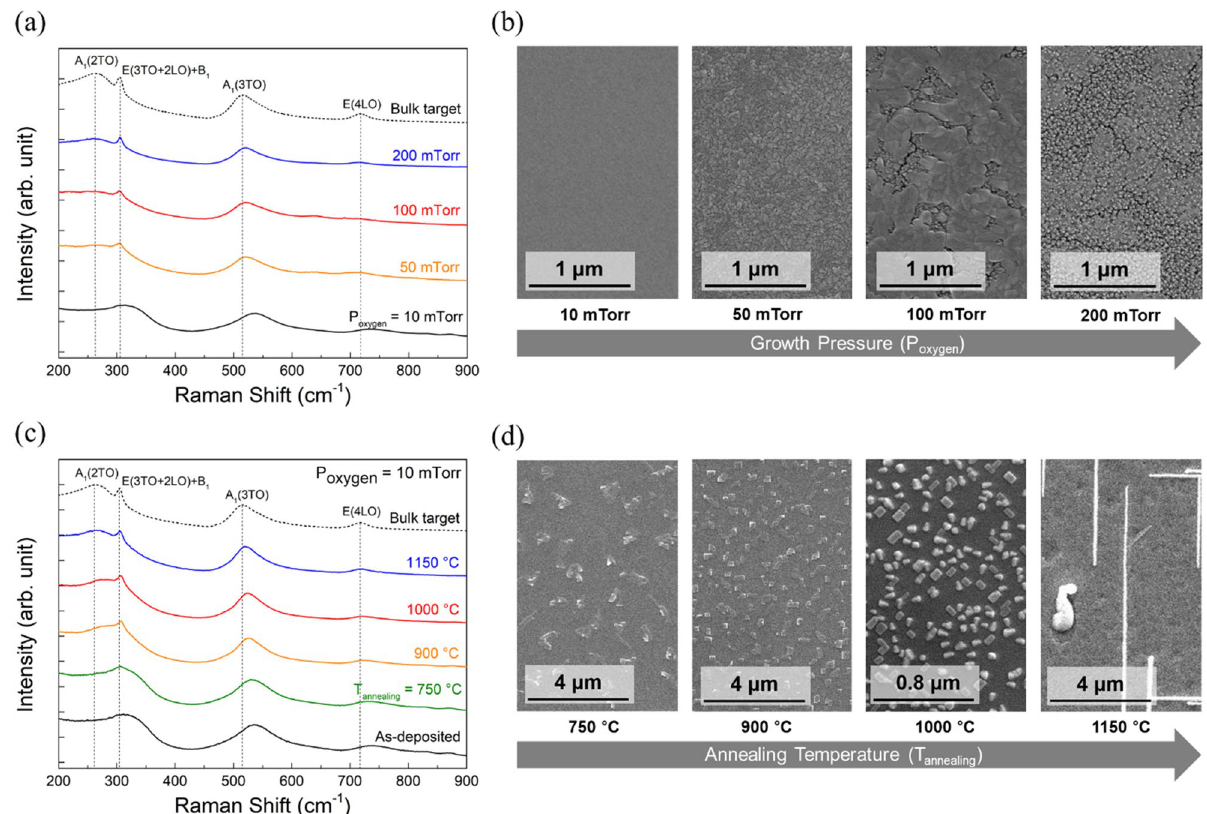
Figure 2. ( a ) Raman spectra of BTO bulk target and BTO films deposited under different oxygen partial pressures (P oxygen ; 10, 50, 100, and 200 mTorr). ( b ) Scanning electron microscopy (SEM) images of BTO films for each oxygen partial pressure. ( c ) Raman spectra of BTO bulk target, as-deposited BTO film, and BTO